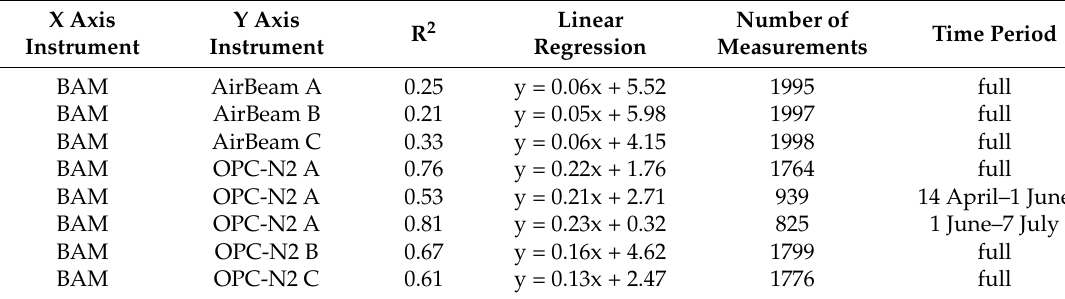
Table 3. Correlation and linear regression of sensor versus BAM PM